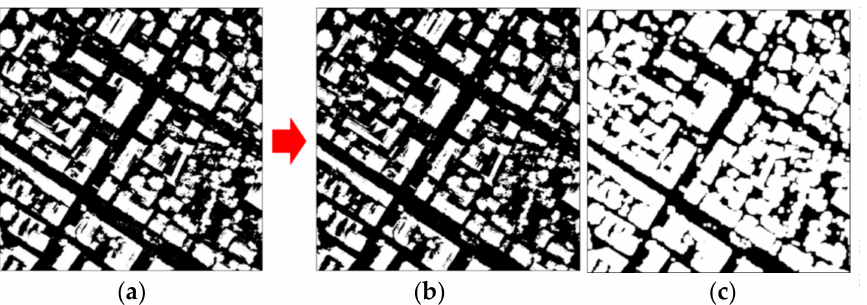
Figure 3. Results of mathematical morphology processing (subsets of original processed DSM with pixel size 1500 × 4000). ( a ) Segmentation image of DSM; ( b ) image after morphological erosion; ( c ) image after morphological dilation, i.e., the result of the opening operation.